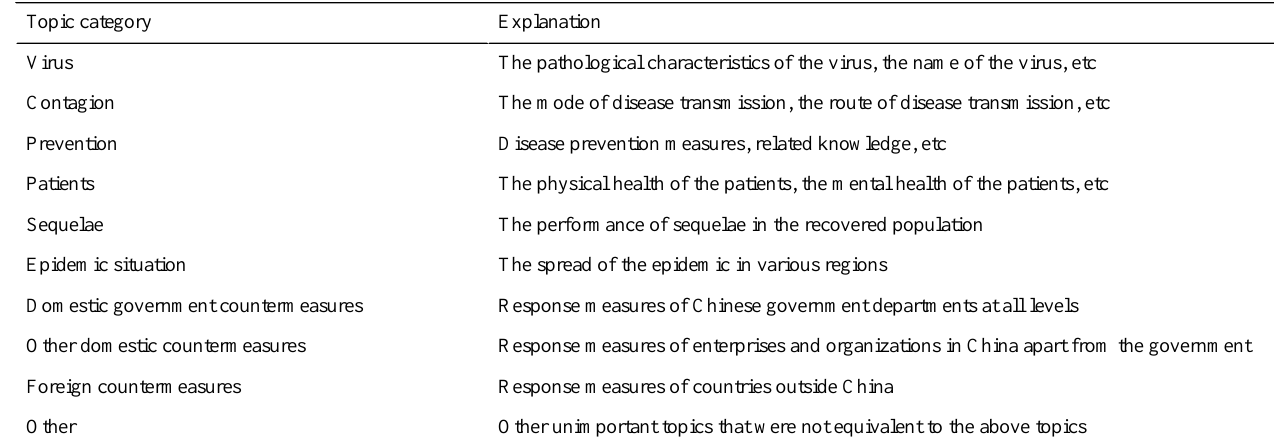
Table 1. Topic categories of original rumor rebuttal tweets. ExplanationTopic